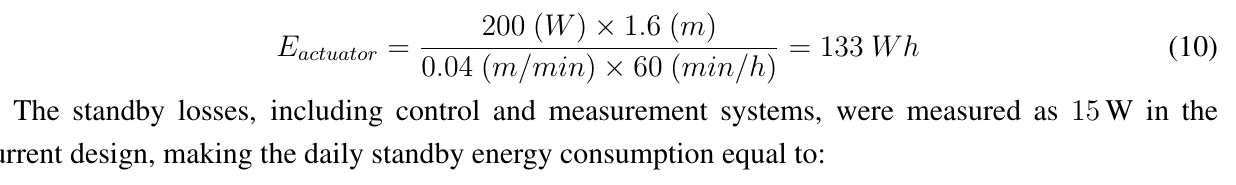
Figure 13. The position of the screw together with the power consumed by the motor, as well as the power required to move the